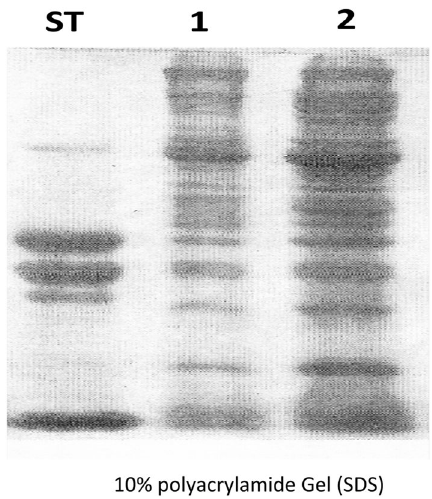
Fig. 6 Electrophoretic of total proteins concentration in untreated and treated honey bee workers hemolymph samples. St: protein